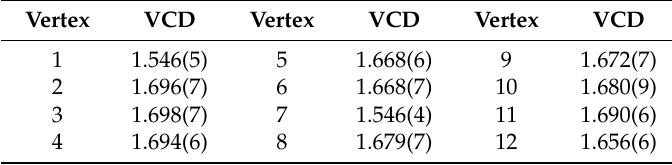
Table 2. Vertex–centroid distances (/Å) in [ closo -1,7-C 2 B 10 H 12 ] 1 . Vertex VCD Vertex VCD Vertex VCD